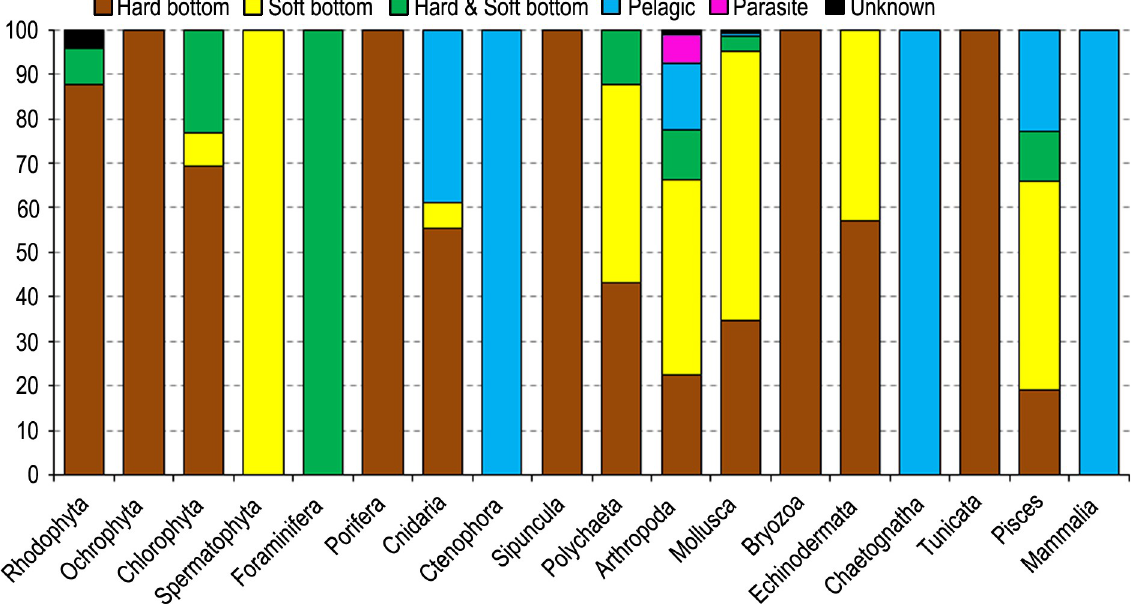
Fig 13. Habitat preferences of alien species in taxonomic groups reported from the coasts of Turkey.